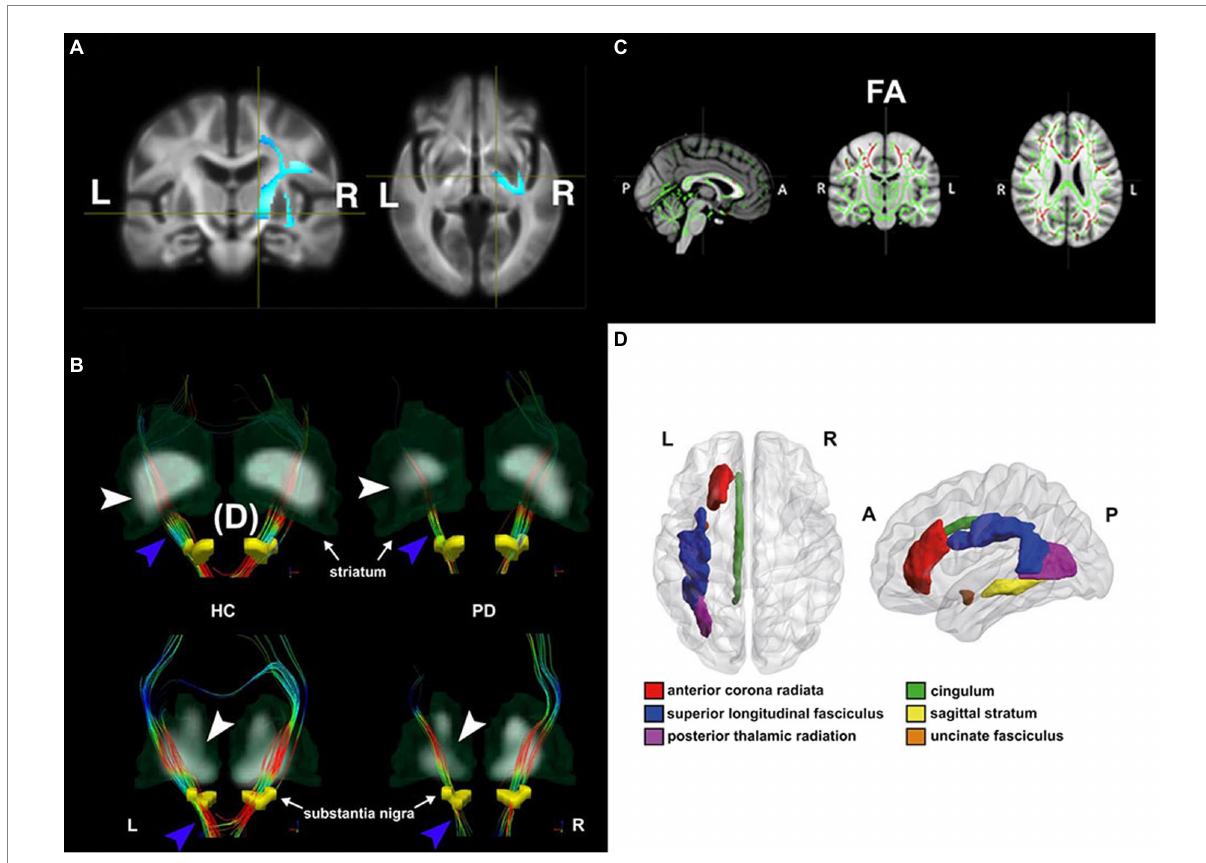
FIGURE 1 Diffusion changes in patients with Parkinson’s disease (PD) with different disease conditions shown by four different DTI analytic methods. (A) De novo PD stage: voxel-based analysis shows lower mean diffusivity (MD) in de novo PD patients relative to healthy controls (HC) in the voxels located at the right corticospinal tract, where the blue color-scale indicates the percentage of effect size. The darkest and lightest blue colors indicate 0 and 6% of the effect size, respectively. In addition, higher fiber cross-section in de novo PD patients was also found in the same brain region. Adapted from Xiao et al. (2021) with permission from John Wiley and Sons (34106502). (B) Early PD stage: tract-specific analysis using deterministic tractography delineates nigrostriatal fiber tracts (blue arrowhead) projecting from the substantia nigra (yellow regions of insterest [ROIs]) to